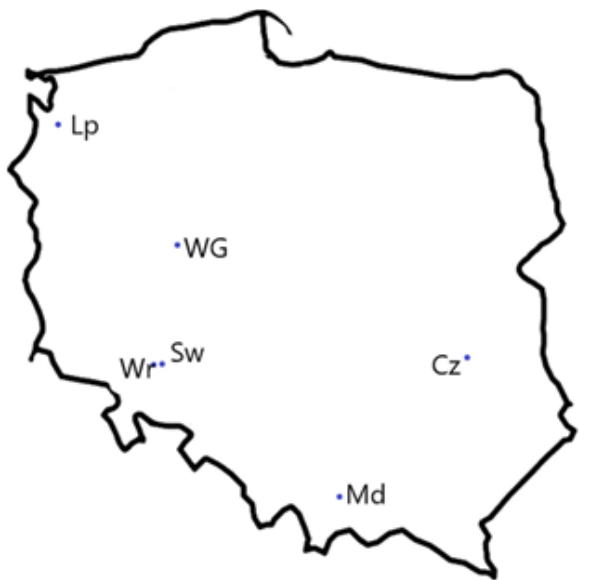
Figure 1. Study site distribution. Lp–Lipnik; WG–Winna Góra; Cz–Czes ł awice; Sw–Swojczyce; Wr–Wroc ł aw; Md–Mydlniki.